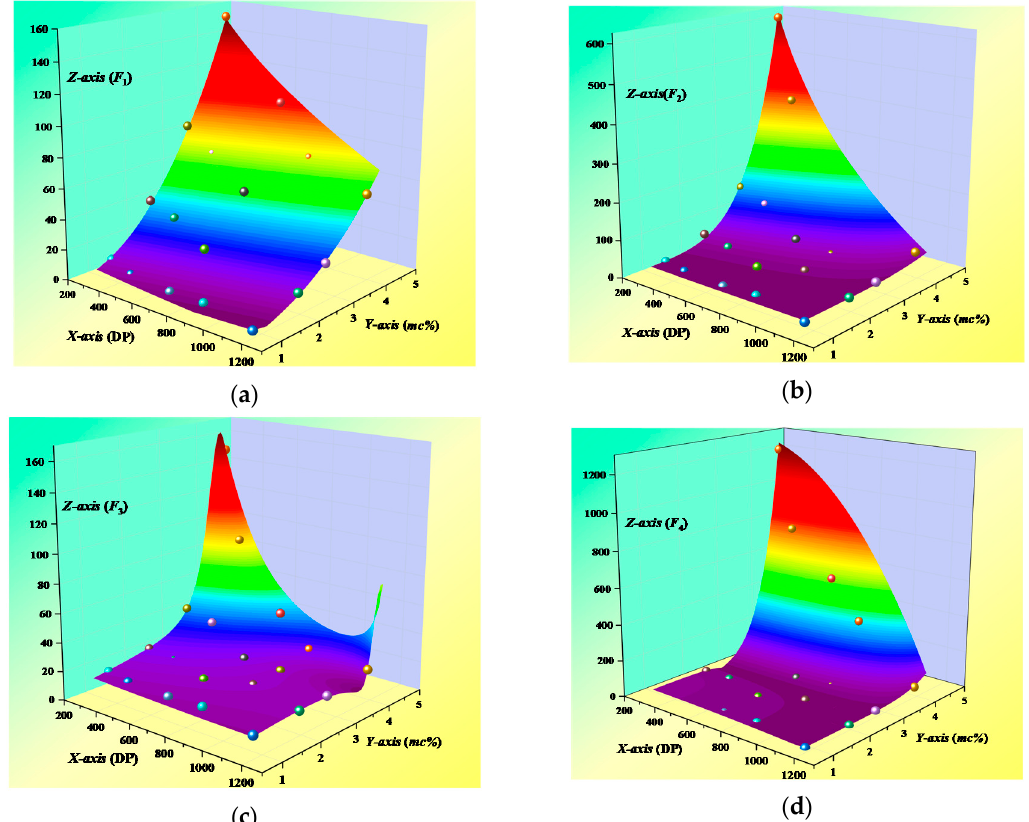
Figure 3. Surface of the fitting analysis model. ( a ) Fitting surface of F 1 ; ( b ) Fitting surface of F 2 ; ( c ) Fitting surface of F 3 ; and ( d ) Fitting surface of F 4 . Table 4. Formula and parameters of the fitting analysis model.